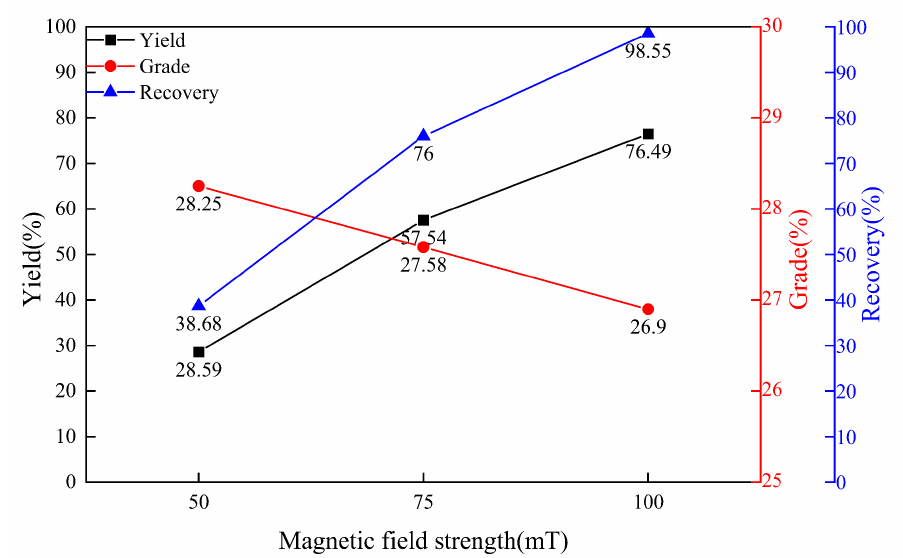
Figure 8. Magnetic separation effect under different magnetic field